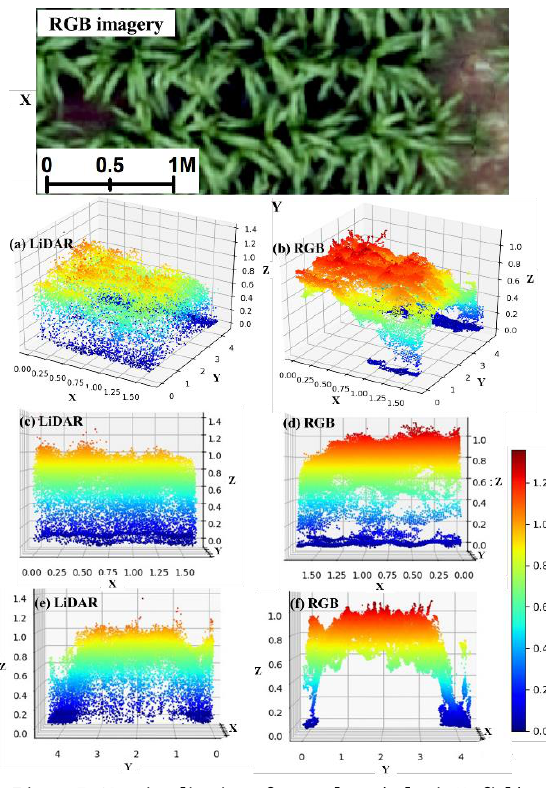
Figure 7. 3D visualization of one selected plot in H-field. (a), (c), (e) are perspective and side views of LiDAR point clouds; (b), (d), (f) are perspective and side views of RGB photogrammetry point clouds.